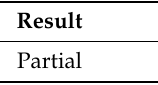
Table 6. Bootstrap mediation analysis